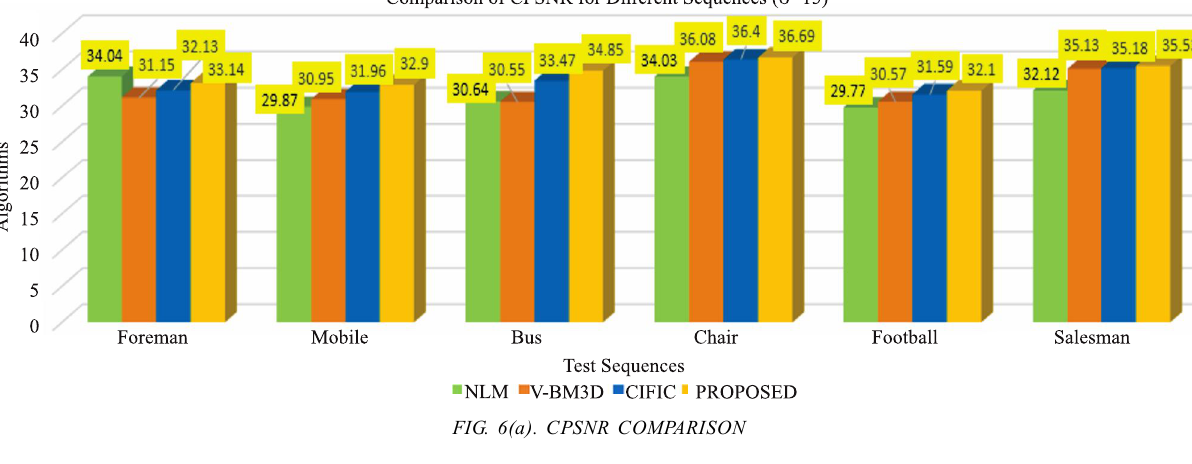
FIG. 5 (i) ZOOMED AREA OF 'C' (J) FIG. 5(j) ZOOMED AREA OF 'C' (J) FIG. 5(k) ZOOMED AREA OF 'C' (J) FIG. 5(l) ZOOMED AREA OF 'C' FIG. 5. COMPARISON OF 58 FRAME OF "BUS" WITH UNIFORM GAUSSIAN NOISE AND ITS ZOOMED AREA SHOWN BY A BLOCK IN ORIGINAL FRAME